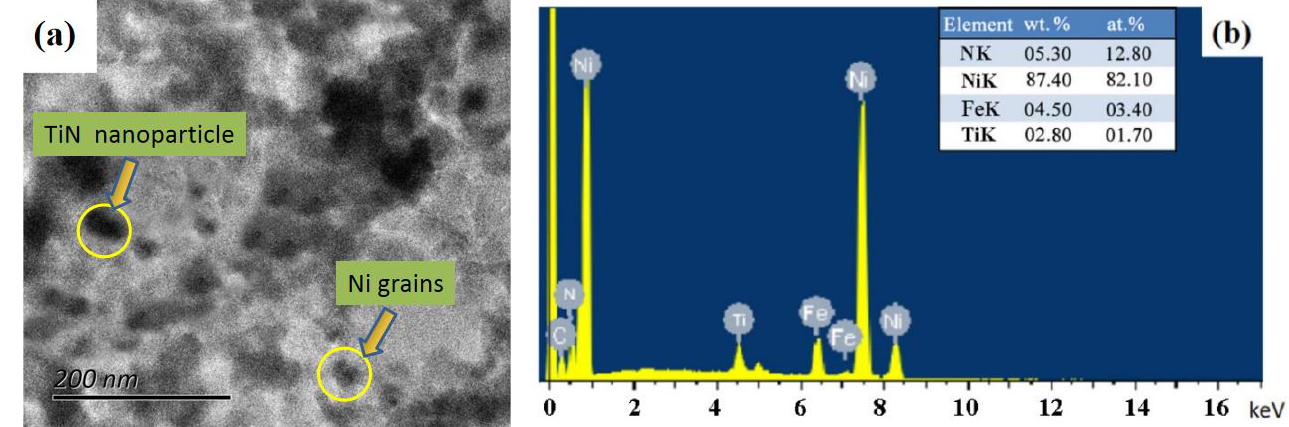
Figure 7. HRTEM ( a ) and EDS images ( b ) of the Ni – TiN nanoplating.